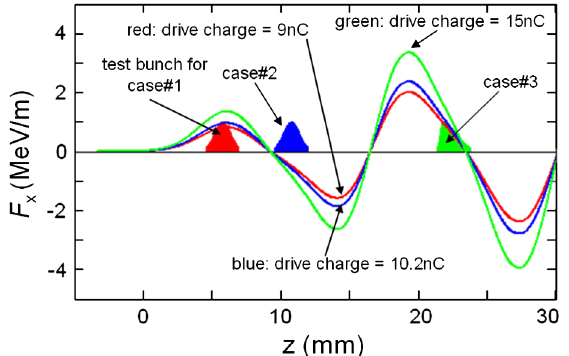
FIG. 19. F x ð z Þ as computed by IVF codes dictates the final velocity spread and distribution; note bunches and wakefields move from right to left, toward lesser z values. F x ð z Þ —force acting on the test bunch (traveling behind the drive bunch at locations marked as case 1, or 2 or 3) is shown here computed for 9 nC of the drive charge (case #1), 10.2 nC of the drive charge (case #2), and 15 nC (case #3). The drive bunch is off the center of its respective channel by 2 mm toward the test channel. For each case the test bunch position and distribution is different, as